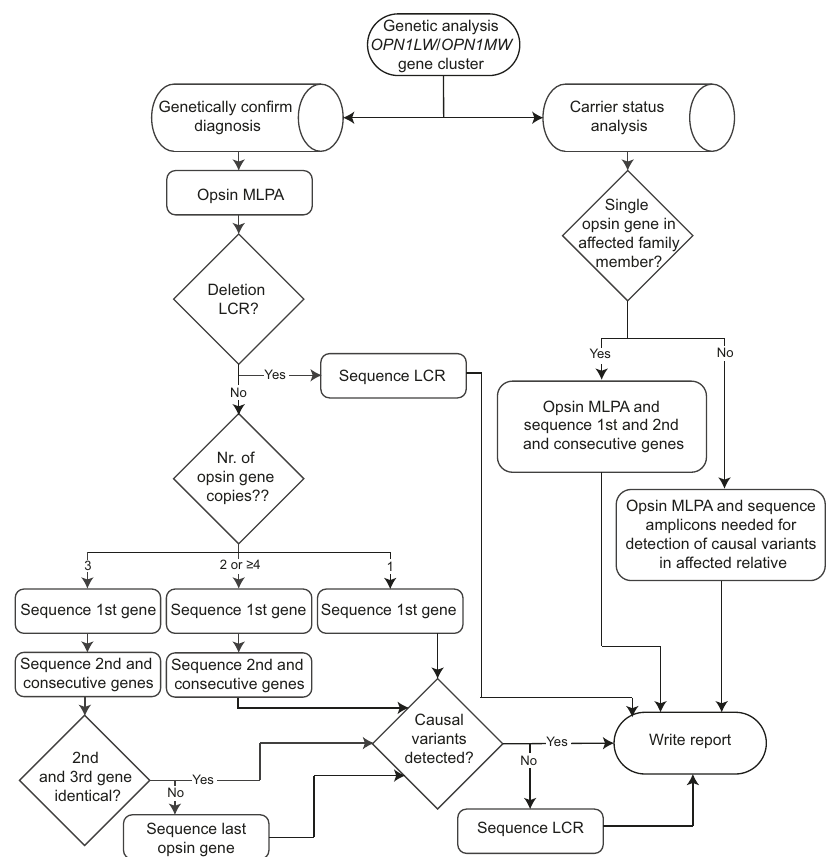
Fig. 3 Flow diagram to determine which genetic tests need to be performed for a clinical sample. The following sequencing strategy was developed for samples in which the clinical question was to genetically con fi rm the clinical diagnosis: (1) If a deletion of the LCR was detected by MLPA the LCR amplicon is sequenced. (2) In samples with a LCR (determined by MLPA) the fi rst gene amplicon is sequenced. (3) In samples with 2 or more genes (determined by MLPA) the second (and consecutive) gene(s) amplicon is sequenced. (4) In samples with three opsin gene copies in the cluster (determined by MLPA) and in which the last two gene copies are not identical (determined by sequencing of second (and consecutive) gene(s) amplicon) the last gene amplicon is sequenced. (5) In samples in which no causal variants are detected (determined by MLPA and sequencing of the fi rst gene, the second (and consecutive) gene(s) and/or last gene amplicons) the LCR amplicon is sequenced. In samples in which the clinical question was carrier status analysis the sequencing strategy depends on the genetic results of the affected relative. In all samples MLPA needs to be performed to determine the number of opsin gene copies. When a single (hybrid) gene is detected in the affected family member, the fi rst gene amplicon and second (and consecutive) gene(s) amplicon need to be sequenced as single (hybrid) genes frequently occur de novo. In the other cases the same amplicons need to be sequenced that were needed to detect causal variants in the affected family